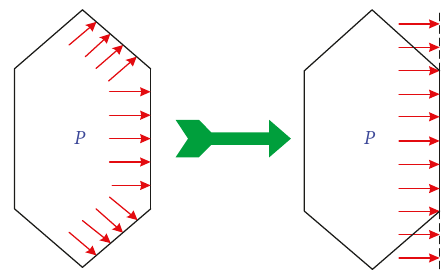
Figure 9: Fluid pressure on the cavity surface.